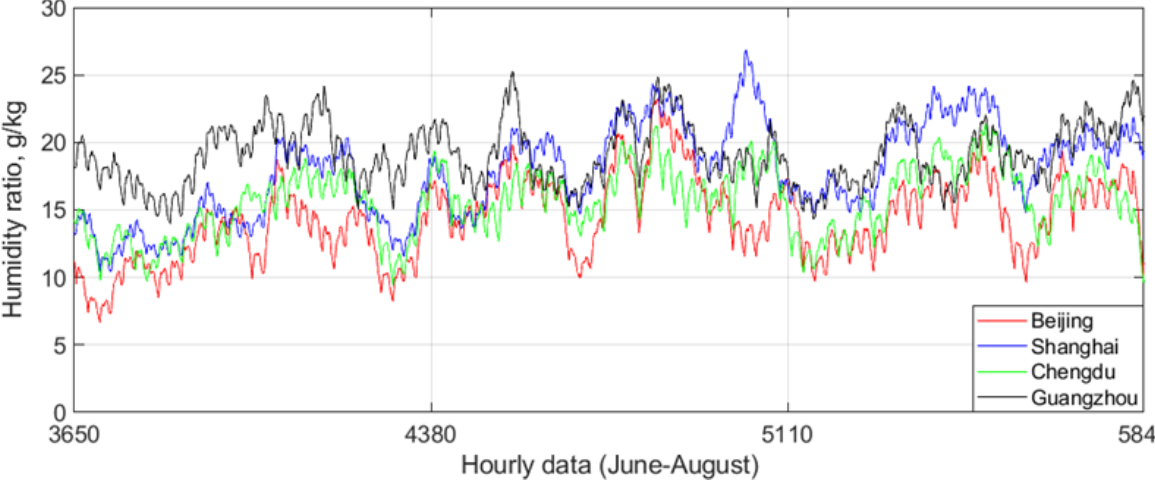
Figure 6. Humidity ratio data for Beijing, Shanghai, Chengdu, and Guangzhou, China .